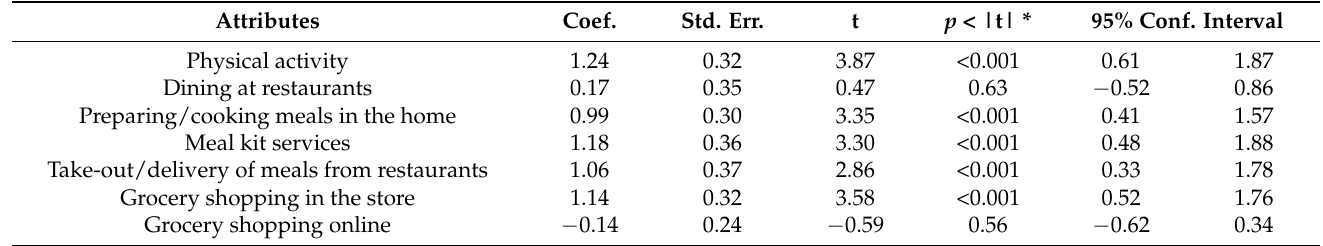
Table 6. Multiple linear regression of impact of other attributes on total dietary habits ( n =